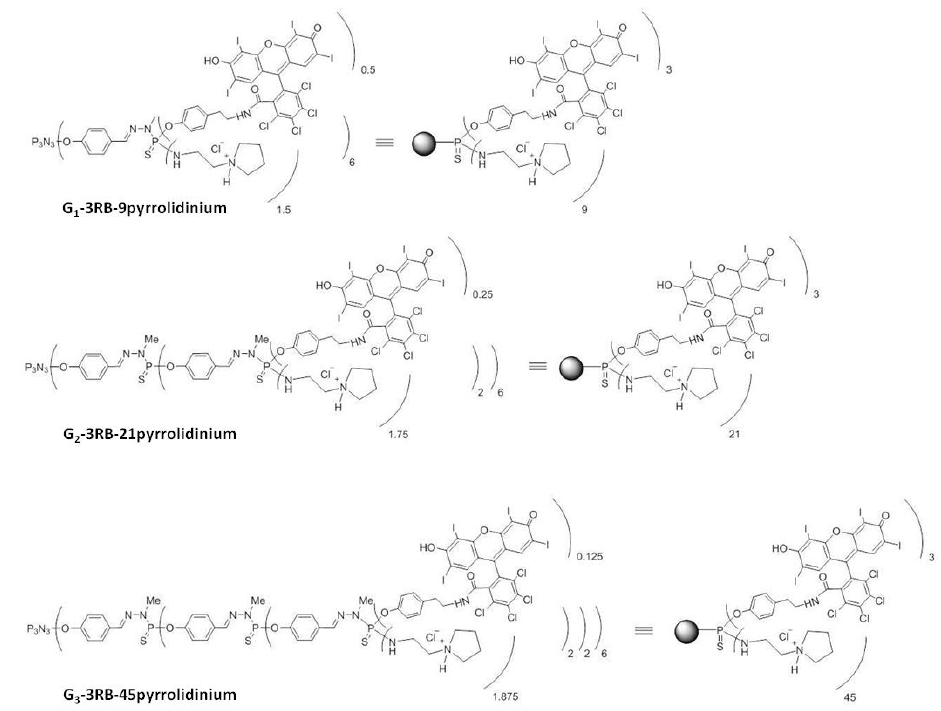
Figure 14. The structures of the G1–, 2–, 3–RB–pyrrolidinium conjugates. Black spheres are graphical representation of non-modified phosphorus dendrimer.